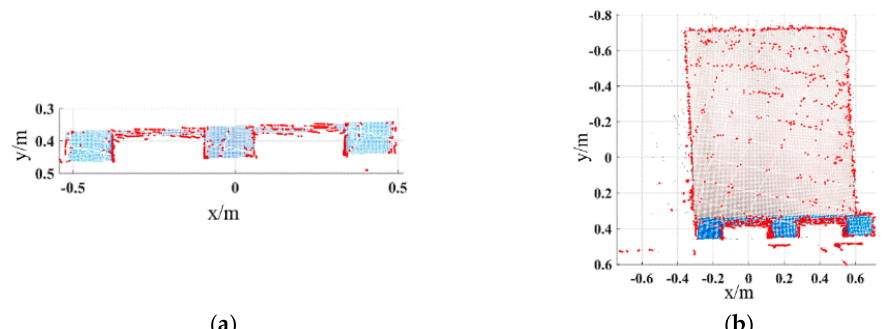
Figure 14. Key points of pallet template point cloud and ground scene point cloud. ( a ) Key points of pallet template point cloud. ( b ) Key points of ground scene point cloud.